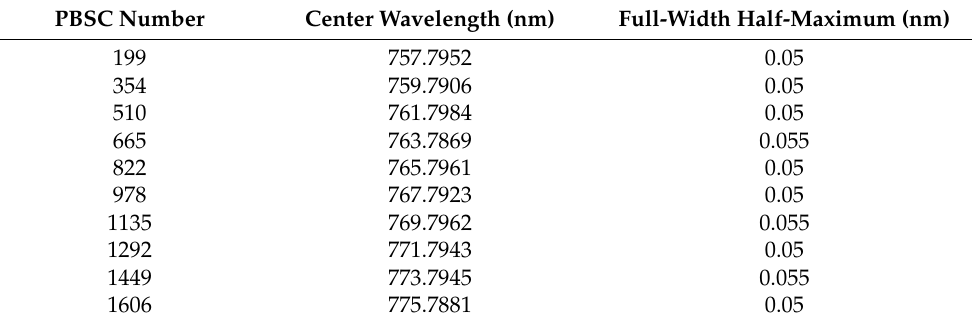
Figure 17. Spectral response function diagram of some PBSCs of molecular oxygen A ‐ band (1, 2, 3 channels) and water vapor absorption band (4, 5, 6 channels): ( a ) Channel 1, 977 PBSC spectral response function (Center wavelength: 767.7798 nm, Full ‐ Width Half ‐ Maximum: <0.050 nm, R 2 = 0.9904, RMSE = 0.03501); ( b ) Channel 2, 977 PBSC spectral response function (Center wavelength: 767.7754 nm, Full ‐ Width Half ‐ Maximum: <0.050 nm, R 2 = 0.9922, RMSE = 0.03094); ( c ) Channel 3, 991 PBSC spectral response function (Center wavelength: 767.7946 nm, Full ‐ Width Half ‐ Maximum: <0.055 nm, R 2 = 0.9870, RMSE = 0.03913); ( d ) Channel 4, 1030 PBSC spectral response function (Center wavelength: 819.993 nm, Full ‐ Width Half ‐ Maximum: <0.23 nm, R 2 = 0.9988, RMSE = 0.01108); ( e ) Channel 5, 1025 PBSC spectral response function (Center wavelength: 819.987 nm, Full ‐ Width Half ‐ Maximum: <0.23 nm, R 2 = 0.9976, RMSE = 0.01613); ( f ) Channel 6, 1020 PBSC spectral response function (Center wavelength: 819.981 nm, Full ‐ Width Half ‐ Maximum: <0.21 nm, R 2 = 0.9952, RMSE = 0.02045). Table 2. Spectral calibration results of molecular oxygen A ‐ band with observation channel (channel 1).